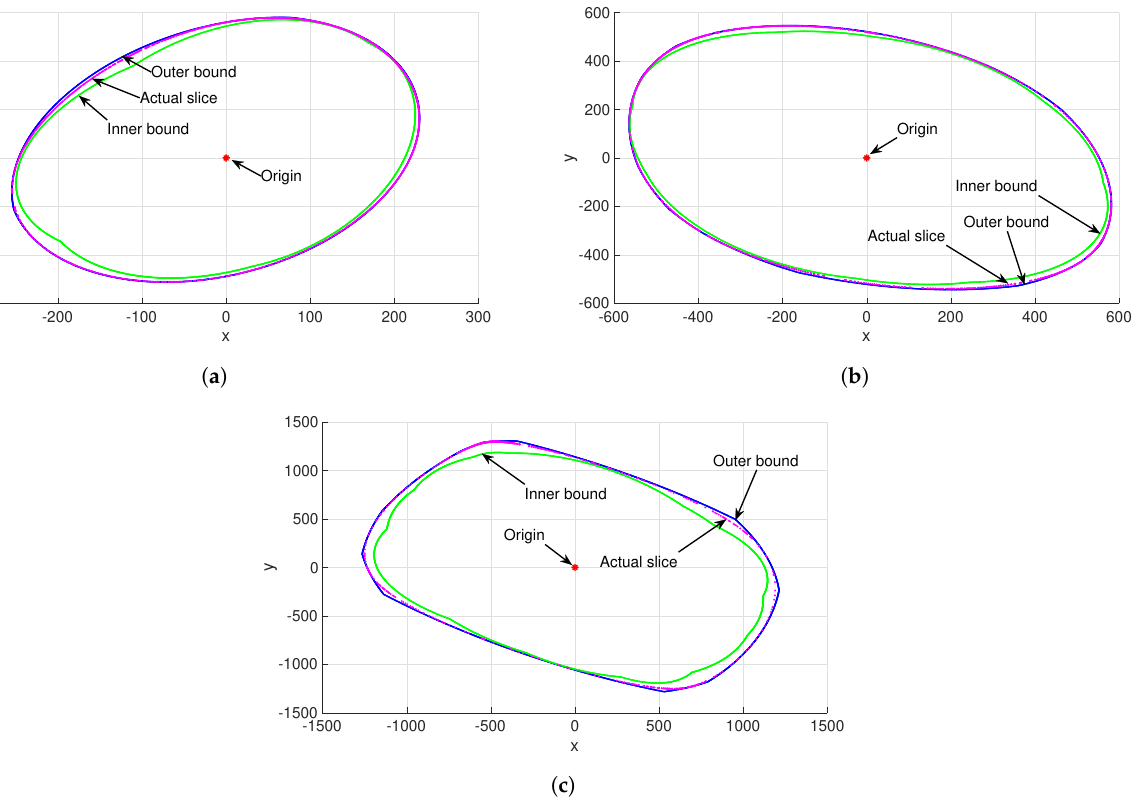
Figure 9. Strips generated by MVOE, four outer Kurzhanski’s, John’s inner and four inner Kurzhansk’s for similar actual slices of Minkowski sums in ( a ): Figure 4e,f, ( b ): Figure 5 and ( c ): Figure